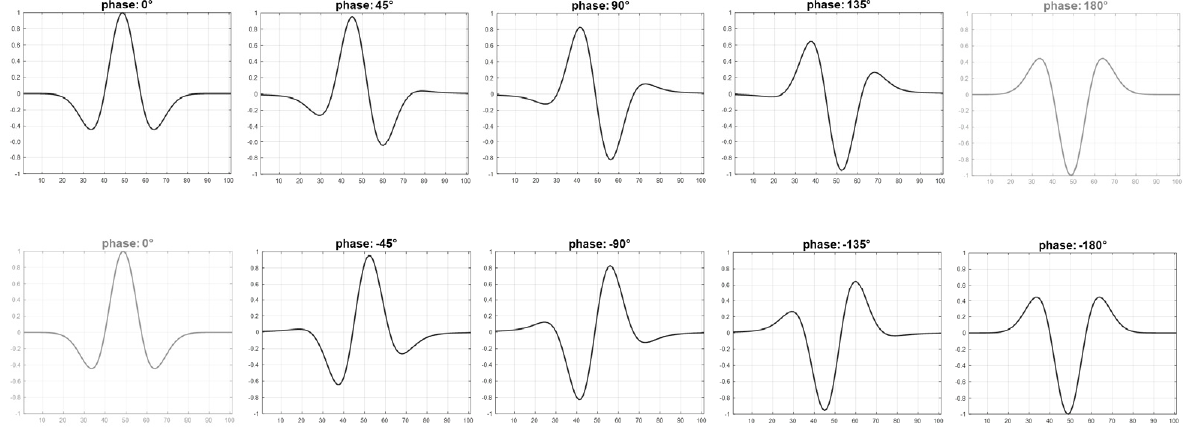
Figure 12. Ricker wavelets with different phase angles.